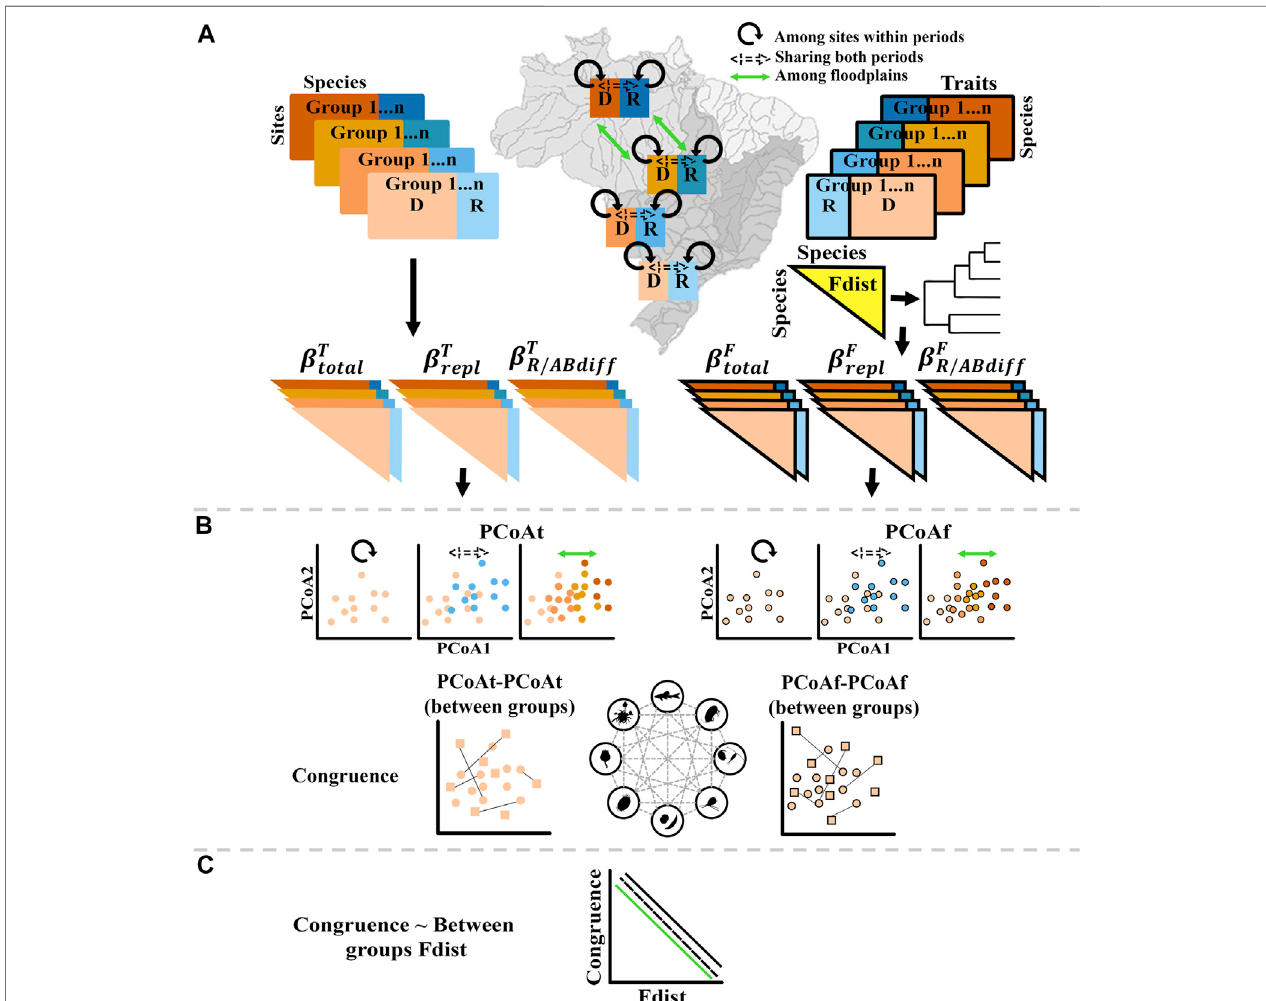
FIGURE2| Summary oftheanalyticalapproach. (A) the combinations ofthethree nested subsets, howthe taxonomic and functionaldatasets areorganized,and thecalculationofeachbetadiversitycomponent. (B) thestepstoobtainthecross-taxoncongruencevalues.First,weperformedaPrincipalCoordinatesAnalysis(PCoA) on each dissimilarity matrix and then the Procrustes correlations between each pair of ordinations, separately for taxonomic and functional data. (C) A Mantel test was carried out between pairs of congruence and functional dissimilarity between biological groups.